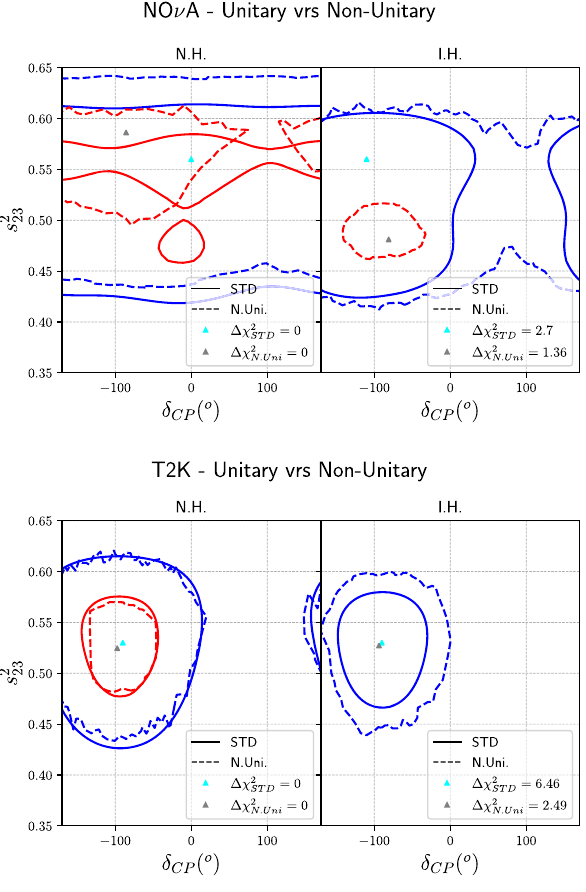
Fig. 11 Allowed regions in the sin 2 θ 23 − δ CP plane for NO ν A (T2K) in the upper (lower) panel. The left (right) panel is for NH (IH). The red (blue)linesindicate1 σ (3 σ )CL.Theminimum χ 2 forNO ν A(T2K)in the case of unitary and non-unitary mixing are 47.92 and 44.38 (123.71 and121.37),respectively.Theparametervaluesatthebest-fitpointhave been mentioned in Table 1 (2) for NO ν A (T2K). These results are for 2019